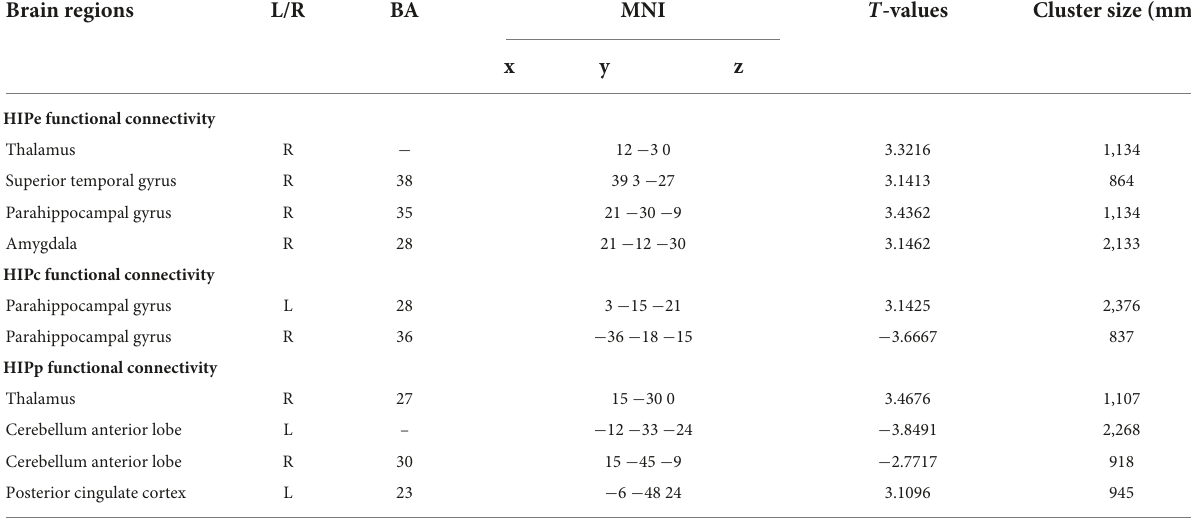
TABLE 2 Comparison of FC in the hippocampal subnetwork between CN and TTumor subjects before surgery in the first cohort. Brain regions L/R BA MNI